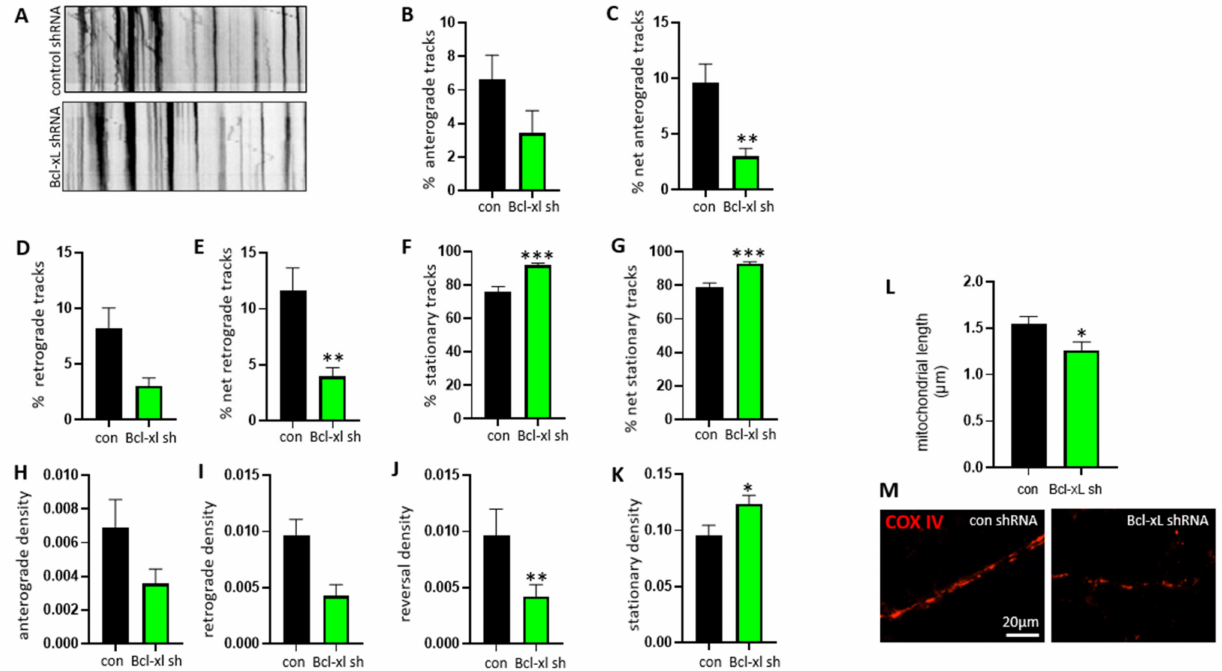
Figure 2. Bcl-xL depletion disrupts mitochondrial motility in primary hippocampal neurons. Primary rat hippocampal neurons were transduced with control shRNA or Bcl-xL shRNA. Kymographs ( A ) were produced and analysis using the KymoAnalyzer was completed to give the percentage of mitochondria that showed mitochondria moving in the following directions: only anterograde ( B ), n = 40, net anterograde ( C ), n = 40, ** p = 0.0022, Mann-Whitney test, only retrograde ( D ), n = 40, net retrograde ( E ), n = 40, ** p = 0.0075, Mann–Whitney test, stationary ( F ), n = 40, *** p = 0.0001, Mann–Whitney test, and net stationary ( G ), n = 40, *** p = 0.0002, Mann–Whitney test. The analysis also provided the mitochondrial density (number of mitochondria/ µ m) for mitochondria exhibiting anterograde ( H ), n = 40 or retrograde ( I ), n = 40 motion, as well as mitochondria that reversed directions ( J ), n = 40, ** p = 0.0029, Mann–Whitney test during the image sequence and stationary mitochondria ( K ), n = 40, * p = 0.0177, Mann–Whitney test. The COX IV protein was labeled to visualize mitochondria ( L , M ), and mitochondria length was measured ( n = 63). * p < 0.05, two-tailed Student’s t -test. Scale bar = 20 µ